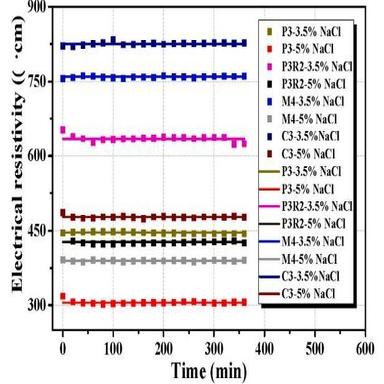
Effect of saturation of solutions with different concentrations on the resistivity of samples.